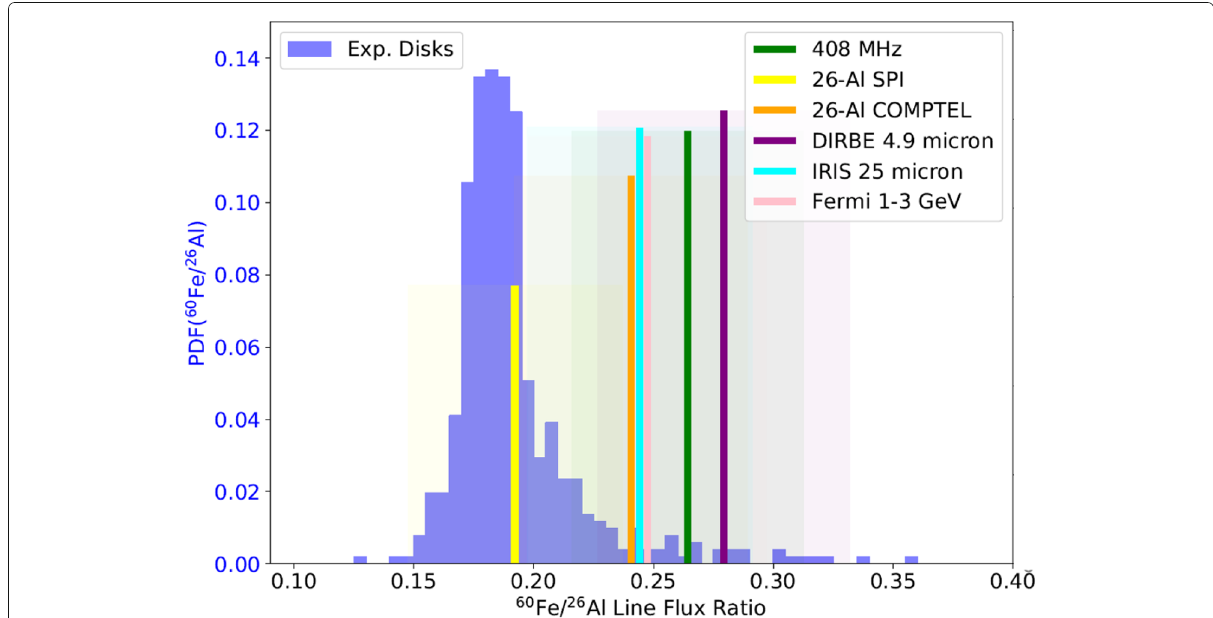
Fig. 4 60 Fe/ 26 Al flux ratio for the grid of exponential disk models (blue). Including the uncertainties of the fluxes from each spectral fit, the total estimated 60 Fe/ 26 Al flux ratio from exponential disks is 0.184 ± 0.042